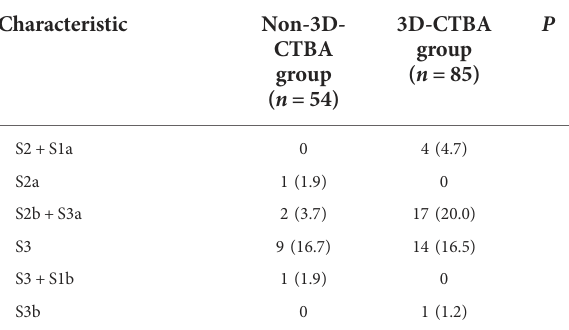
( Table 3 ). 3D-CTBA (Beta = − 13.027, 95% CI: − 18.632 to